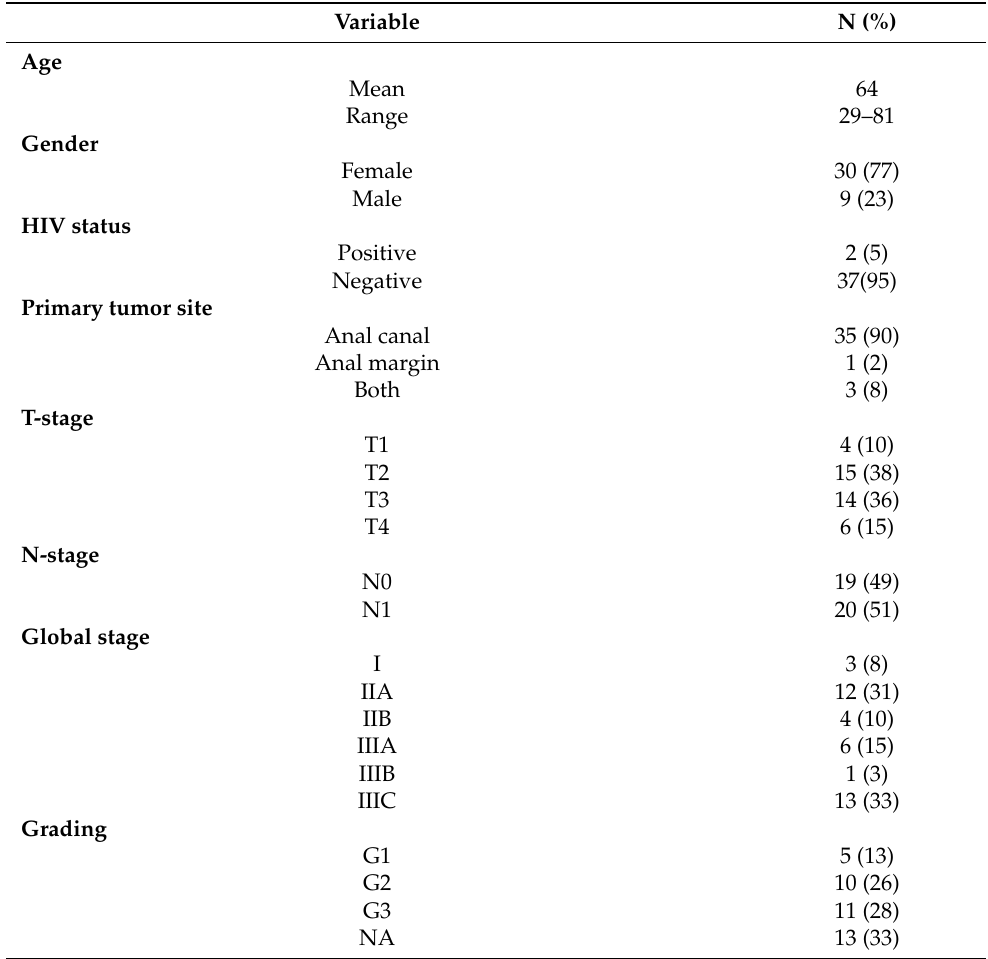
Table 1. Patient and tumor